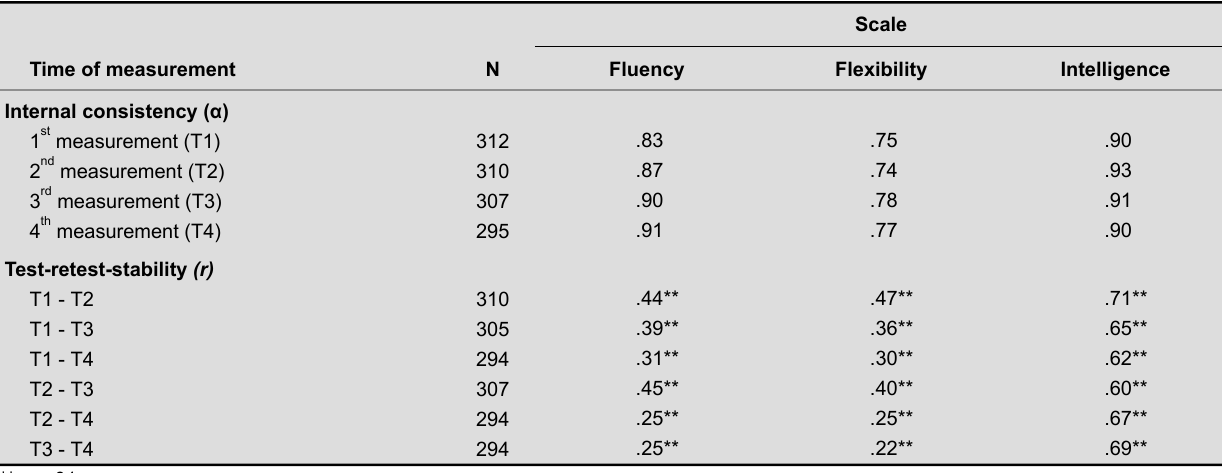
Coefficients of Internal Consistency (Cronbach’s α) at the Four Times of Measurement and Coefficients of Test-Retest Stability Between the Four Times of Measurement in the German Sample